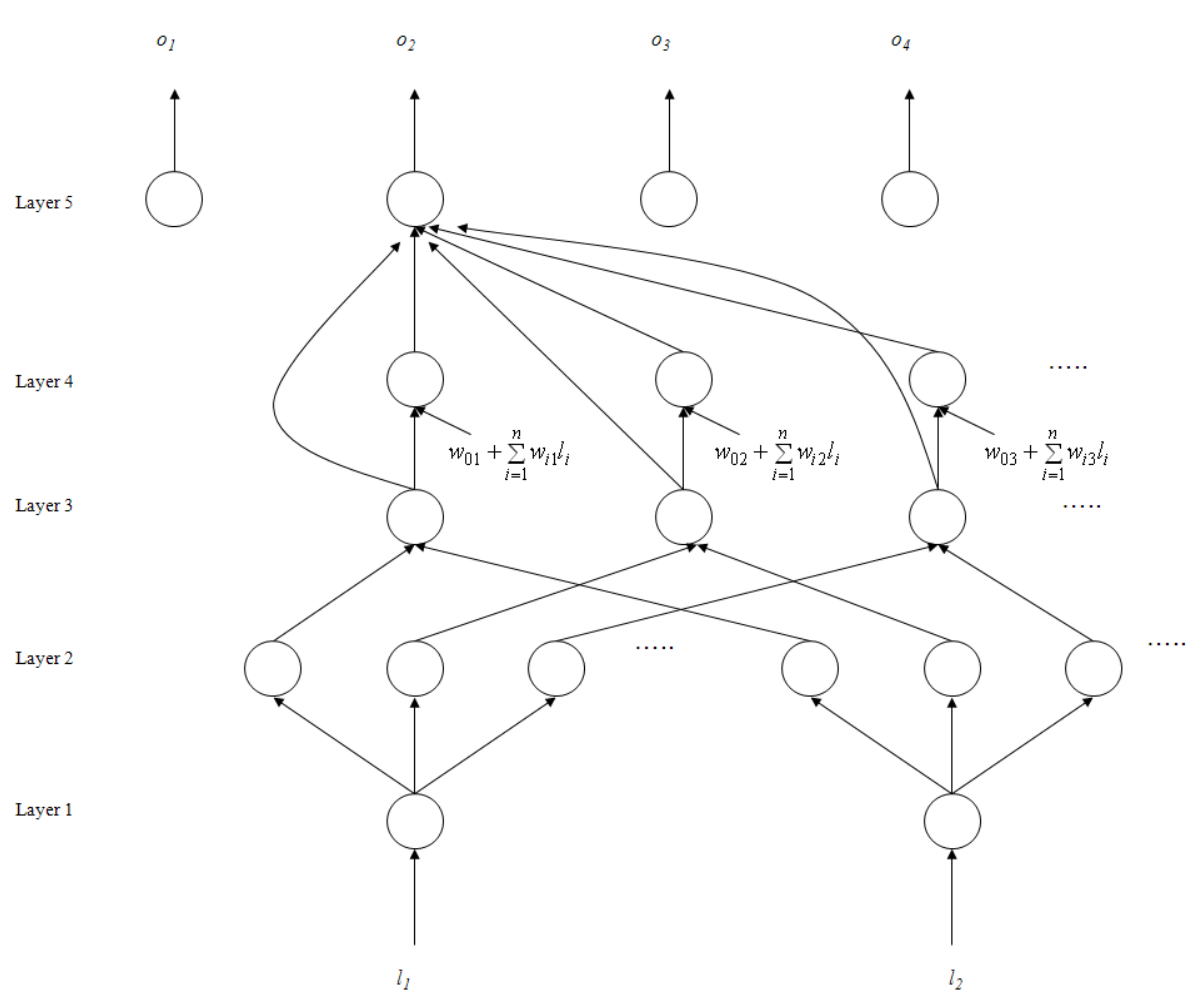
Figure 2. Structure of the